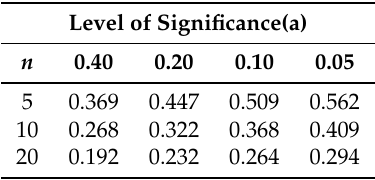
Table 1. Partial value of D ( n , a )